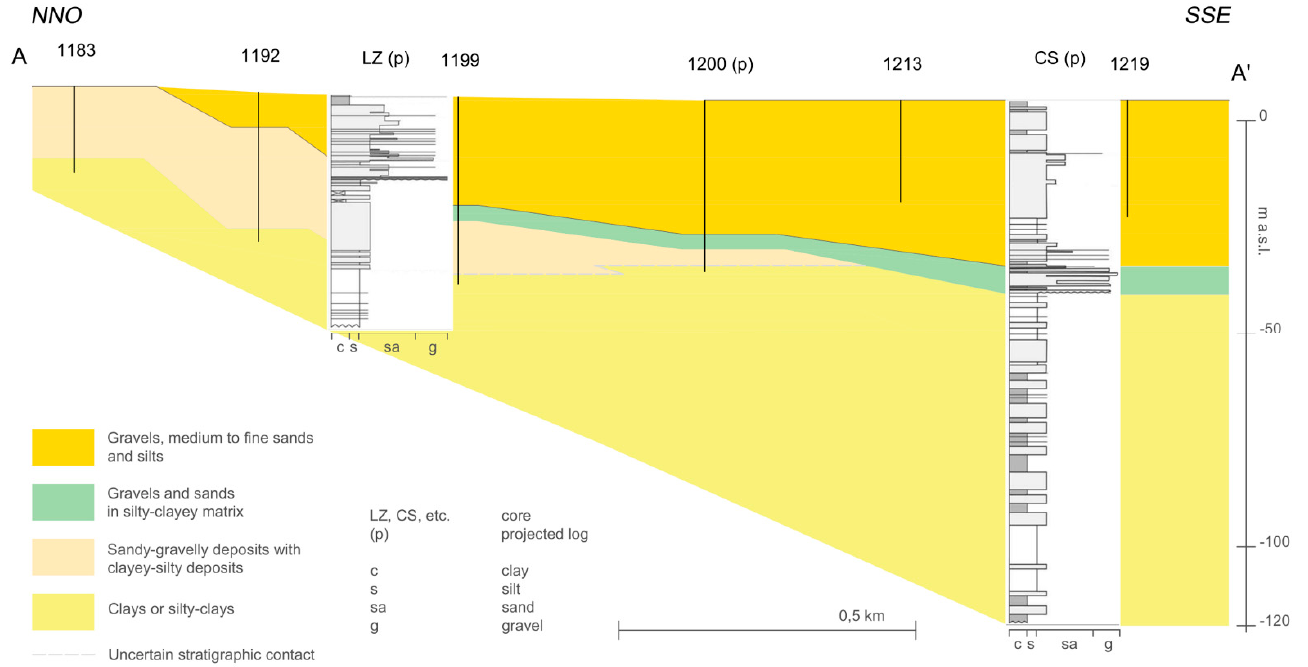
Figure 2. Schematic cross section AA’ (see Figure 1 for location) of the Metaponto coastal plain strat- igraphic units (adapted from Geological Map of Italy 1:50,000 scale [55]). stratigraphic units (adapted from Geological Map of Italy 1:50,000 scale